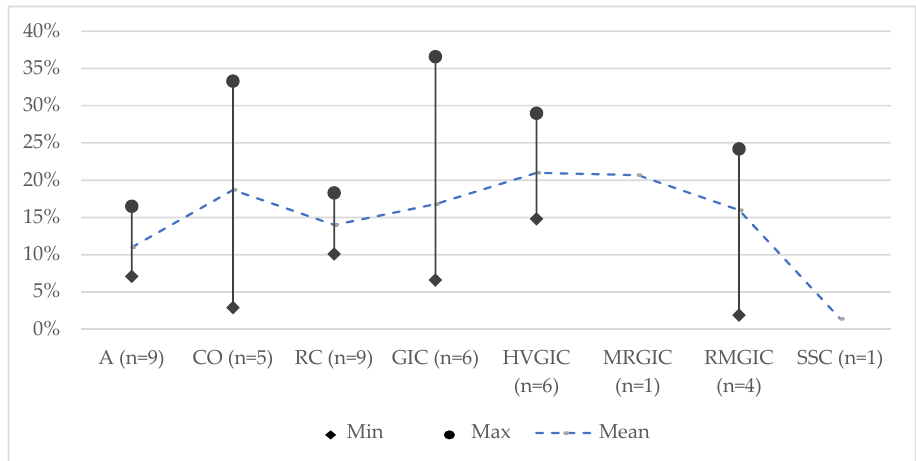
0% Figure 2. The failure rate of restorative materials at 24 months. Abbreviations: A: amalgam; CO: Figure 2. The failure rate of restorative materials at 24 months. Abbreviations: A: amalgam; CO: Figure 2. The failure rate of restorative materials at 24 months. Abbreviations: A: amalgam; CO: Figure 2. The failure rate of restorative materials at 24 months. Abbreviations: A: amalgam; CO: Figure 2. The failure rate of restorative materials at 24 months. Abbreviations: A: amalgam; CO: compomer; GIC: glass-ionomer cement; HVGIC: high-viscosity glass-ionomer cement; MRGIC: compomer; GIC: glass-ionomer cement; HVGIC: high-viscosity glass-ionomer cement; MRGIC: compomer; GIC: glass-ionomer cement; HVGIC: high-viscosity glass-ionomer cement; MRGIC: compomer; GIC: glass-ionomer cement; HVGIC: high-viscosity glass-ionomer cement; MRGIC: metal-reinforced glass-ionomer cement; RC: resin composite; RMGIC: resin-modified glass-iono- metal-reinforced glass-ionomer cement; RC: resin composite; RMGIC: resin-modified glass-iono- metal-reinforced glass-ionomer cement; RC: resin composite; RMGIC: resin-modified glass-iono- Figure 2. The failure rate of restorative materials at 24 months. Abbreviations: A: amalgam; CO: Figure 2. The failure rate of restorative materials at 24 months. Abbreviations: A: amalgam; CO: mer cement; SSC: stainless steel crown; n: represents the number of reviews in which the efficacy mer cement; SSC: stainless steel crown; n: represents the number of reviews in which the efficacy mer cement; SSC: stainless steel crown; n: represents the number of reviews in which the efficacy mer cement; SSC: stainless steel crown; n: represents the number of reviews in which the efficacy Figure 2. The failure rate of restorative materials at 24 months. Abbreviations: A: amalgam; CO: compomer; GIC: glass-ionomer cement; HVGIC: high-viscosity glass-ionomer cement; MRGIC: compomer; GIC: glass-ionomer cement; HVGIC: high-viscosity glass-ionomer cement; MRGIC: of the specific material was assessed; Min: minimum value for failure rate; Max: maximum value of the specific material was assessed; Min: minimum value for failure rate; Max: maximum value of the specific material was assessed; Min: minimum value for failure rate; Max: maximum value of the specific material was assessed; Min: minimum value for failure rate; Max: maximum value compomer; GIC: glass-ionomer cement; HVGIC: high-viscosity glass-ionomer cement; MRGIC: metal-reinforced glass-ionomer cement; RC: resin composite; RMGIC: resin-modified glass-iono- metal-reinforced glass-ionomer cement; RC: resin composite; RMGIC: resin-modified glass-iono- for failure rate. for failure rate. for failure rate. Figure 2. The failure rate of restorative materials at 24 months. Abbreviations: A: amalgam; CO: Figure 2. The failure rate of restorative materials at 24 months. Abbreviations: A: amalgam; CO: for failure rate. metal-reinforced glass-ionomer cement; RC: resin composite; RMGIC: resin-modified glass-iono- mer cement; SSC: stainless steel crown; n: represents the number of reviews in which the efficacy mer cement; SSC: stainless steel crown; n: represents the number of reviews in which the efficacy compomer; GIC: glass-ionomer cement; HVGIC: high-viscosity glass-ionomer cement; MRGIC: compomer; GIC: glass-ionomer cement; HVGIC: high-viscosity glass-ionomer cement; MRGIC: mer cement; SSC: stainless steel crown; n: represents the number of reviews in which the efficacy of the specific material was assessed; Min: minimum value for failure rate; Max: maximum value of the specific material was assessed; Min: minimum value for failure rate; Max: maximum value metal-reinforced glass-ionomer cement; RC: resin composite; RMGIC: resin-modified glass-iono- metal-reinforced glass-ionomer cement; RC: resin composite; RMGIC: resin-modified glass-iono- of the specific material was assessed; Min: minimum value for failure rate; Max: maximum value for failure rate. for failure rate. Figure 2. The failure rate of restorative materials at 24 months. Abbreviations: A: amalgam; CO: Figure 2. The failure rate of restorative materials at 24 months. Abbreviations: A: amalgam; mer cement; SSC: stainless steel crown; n: represents the number of reviews in which the efficacy mer cement; SSC: stainless steel crown; n: represents the number of reviews in which the efficacy for failure rate. compomer; GIC: glass-ionomer cement; HVGIC: high-viscosity glass-ionomer cement; MRGIC: Figure 2. The failure rate of restorative materials at 24 months. Abbreviations: A: amalgam; CO: CO: compomer; GIC: glass-ionomer cement; HVGIC: high-viscosity glass-ionomer cement; MRGIC: of the specific material was assessed; Min: minimum value for failure rate; Max: maximum value of the specific material was assessed; Min: minimum value for failure rate; Max: maximum value metal-reinforced glass-ionomer cement; RC: resin composite; RMGIC: resin-modified glass-iono- compomer; GIC: glass-ionomer cement; HVGIC: high-viscosity glass-ionomer cement; MRGIC: for failure rate. for failure rate. metal-reinforced glass-ionomer cement; RC: resin composite; RMGIC: resin-modified glass-ionomer mer cement; SSC: stainless steel crown; n: represents the number of reviews in which the efficacy metal-reinforced glass-ionomer cement; RC: resin composite; RMGIC: resin-modified glass-iono- of the specific material was assessed; Min: minimum value for failure rate; Max: maximum value cement; SSC: stainless steel crown; n: represents the number of reviews in which the efficacy of mer cement; SSC: stainless steel crown; n: represents the number of reviews in which the efficacy for failure rate. the specific material was assessed; Min: minimum value for failure rate; Max: maximum value for of the specific material was assessed; Min: minimum value for failure rate; Max: maximum value failure for failure rate.